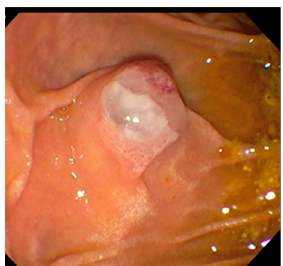
Figure 3. Intraductal papillary neoplasm of the pancreatic duct.